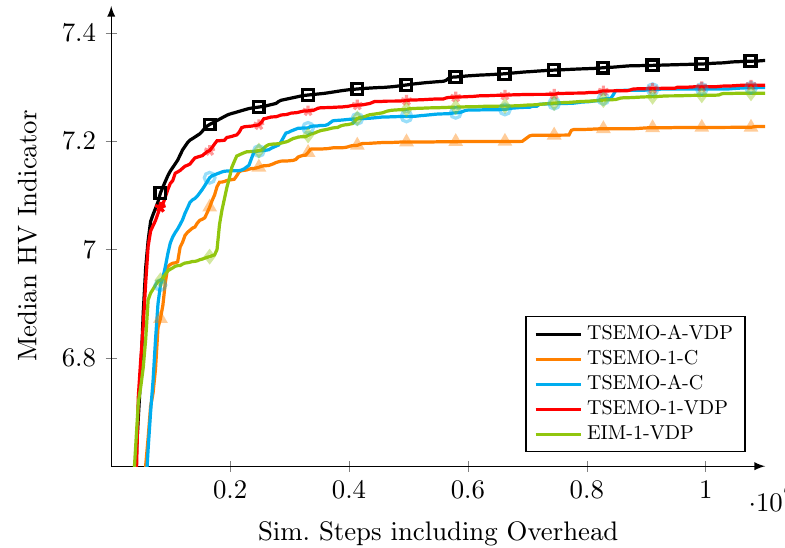
Figure 4. HV indicator as a function of simulation steps including algorithmic overhead. Markers in light colors indicate that the HV indicator of the respective algorithm is statistically significantly worse than the best BO